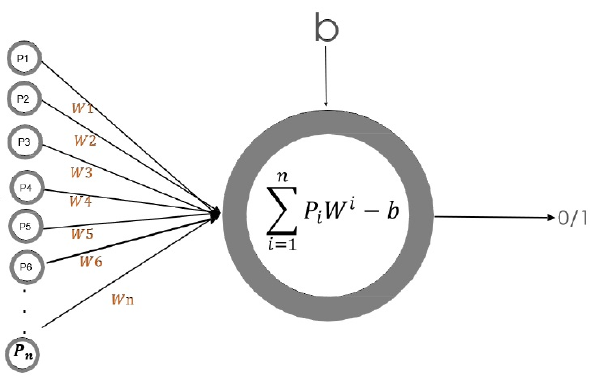
Figure 2. Perceptron or basic artificial neuron.